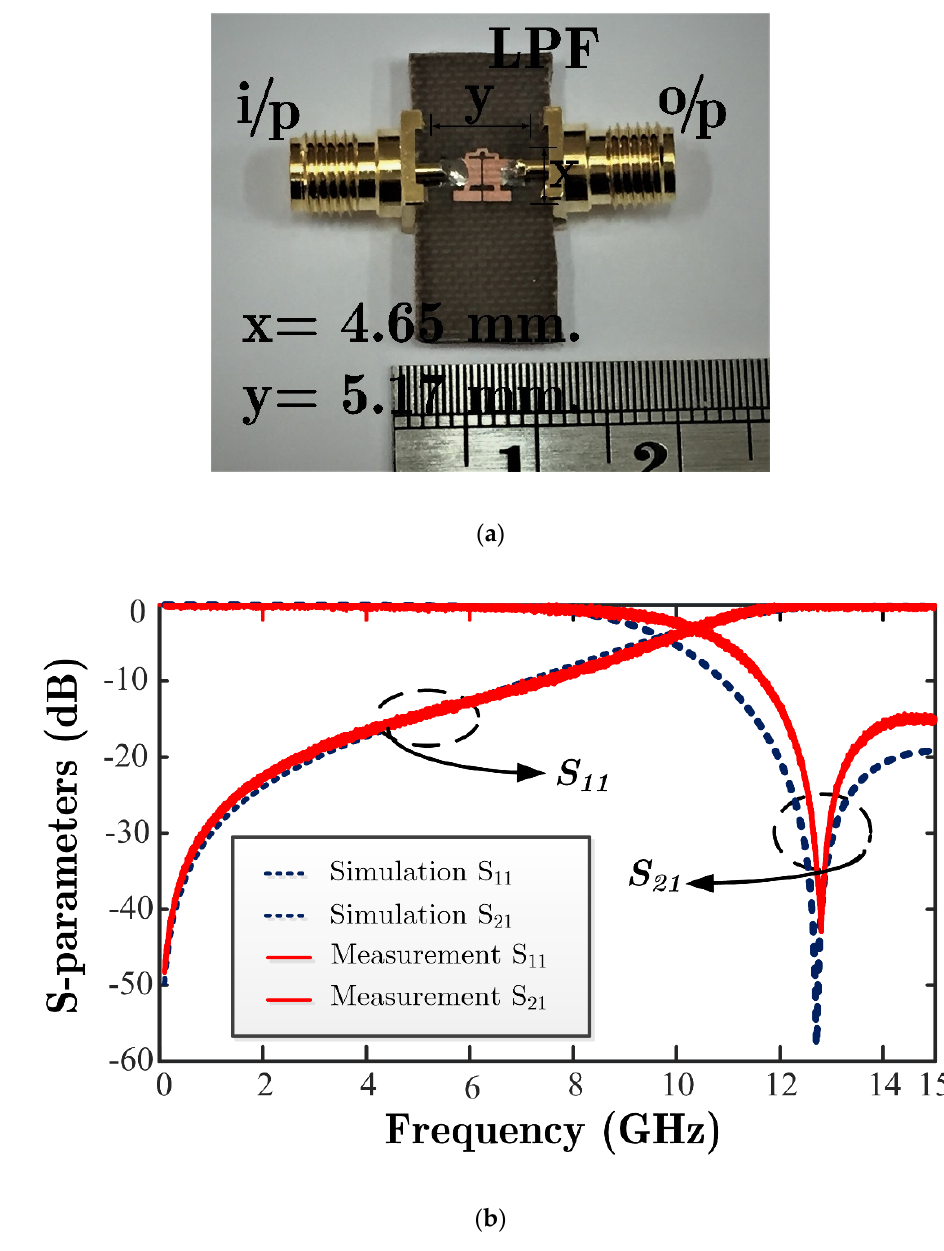
Figure 8. The prototype of the LPF: ( a ) A photograph of the LPF and ( b ) the simulated and measured results of the LPF with compensated inductors ( L p = 0.2 nH). Table 3. Result comparison with other UWB